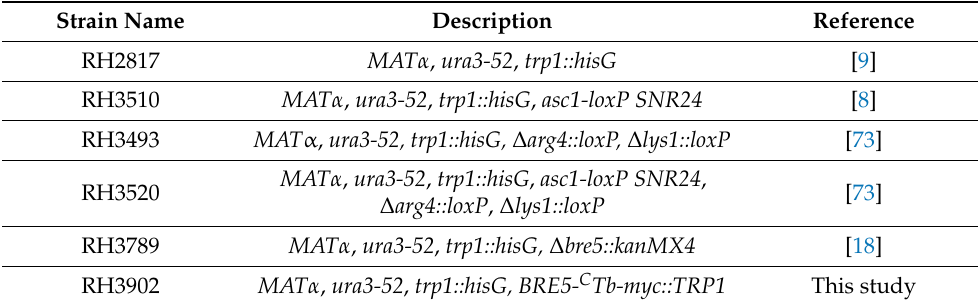
Table 2. S. cerevisiae strains used in this